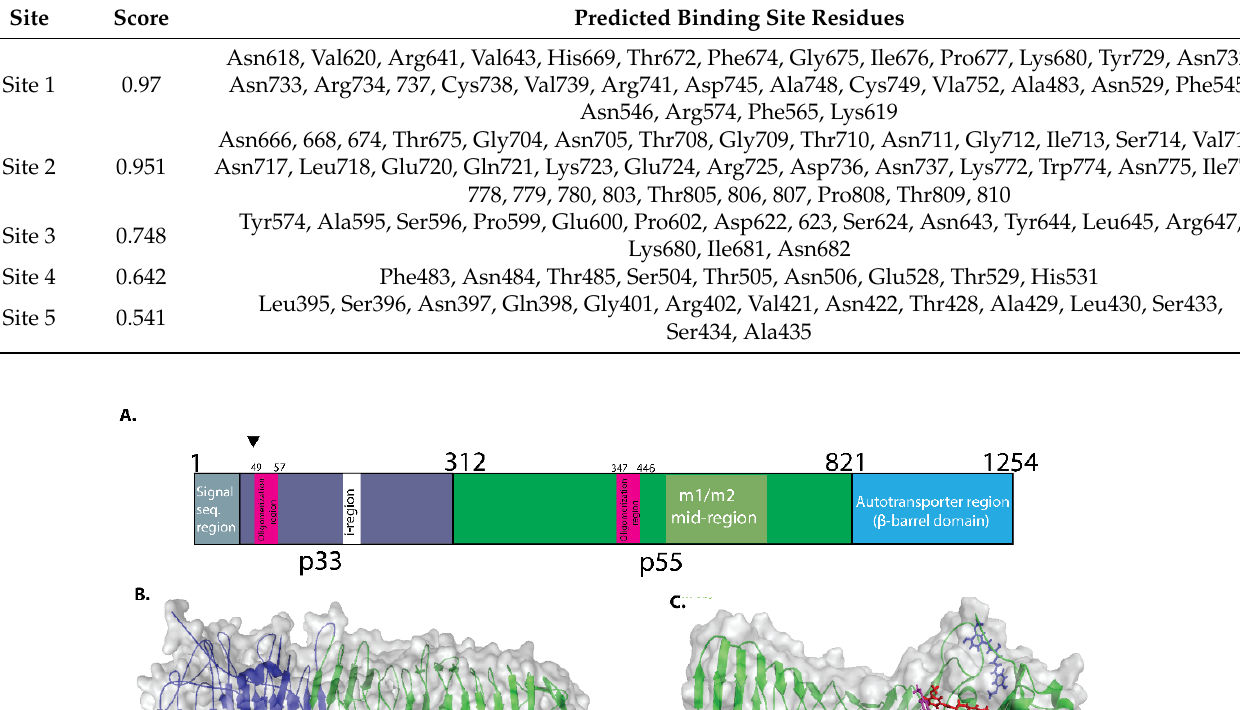
Table 1. Curcumin binding sites in p55 domain of VacA.